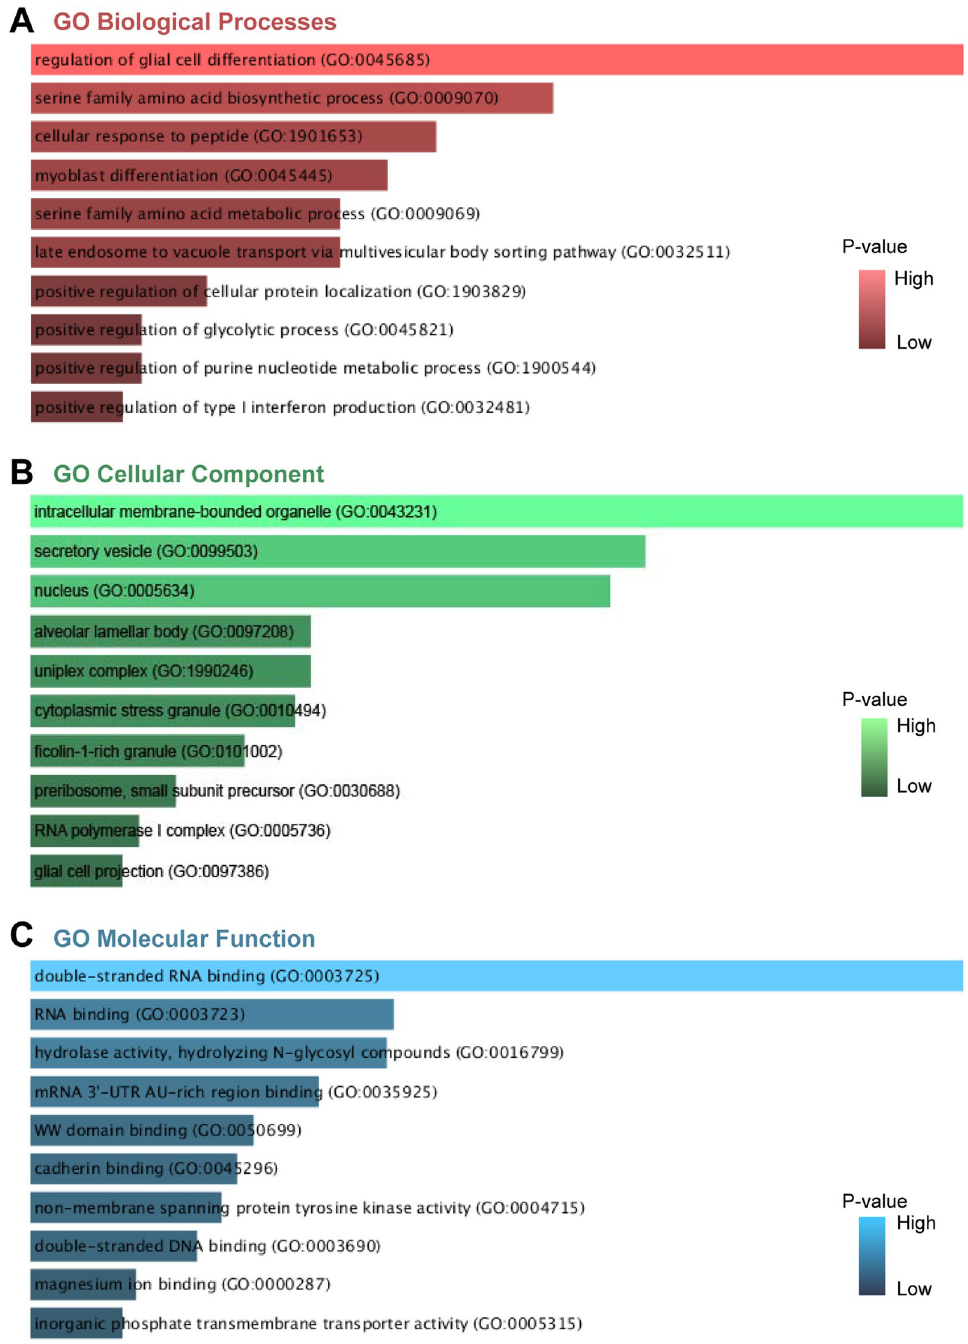
Figure 3. GO terms of common genes between EBV infection, SLE and DLBCL. ( A ) Biological Processes, ( B ) cellular component, ( C ) molecular